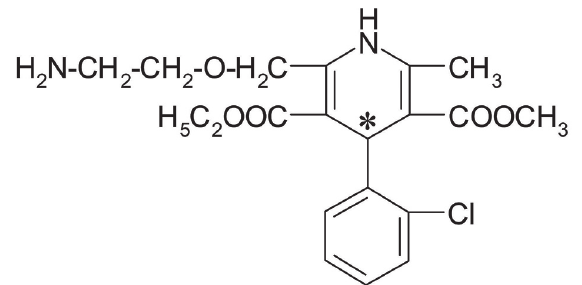
FIGURE 1 - Chemical structure of AML (* denotes the chiral